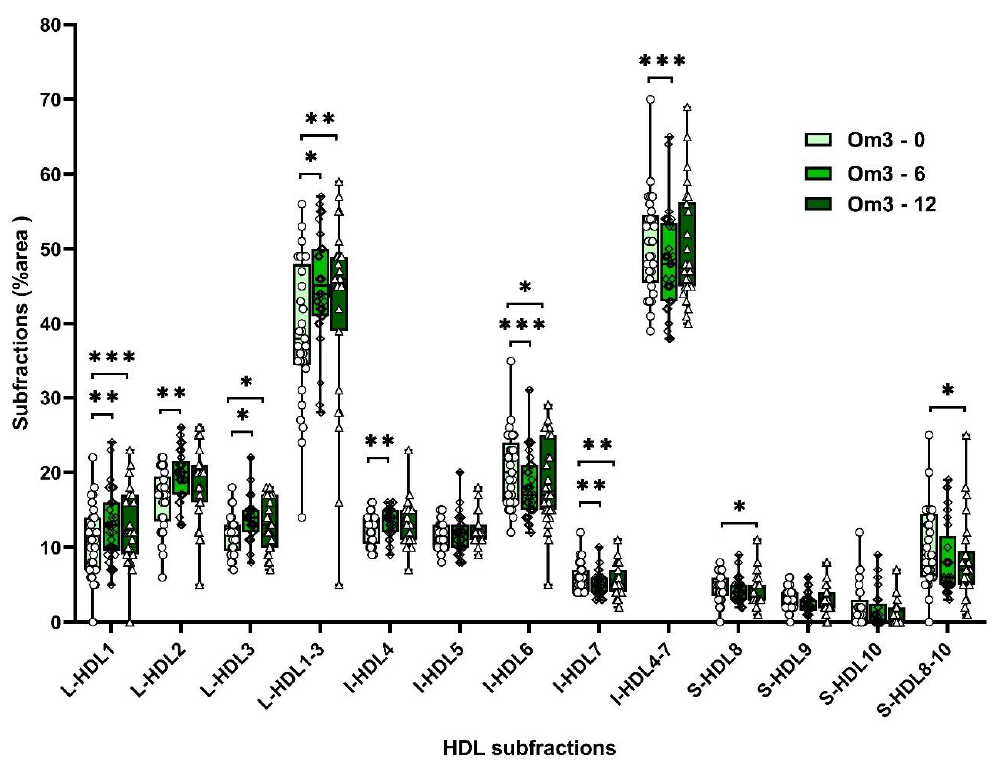
Figure 5. HDL subfractions in Om3 group at the baseline and after 6 and 12 weeks of supplementation. HDL—high-density lipoprotein, L-HDL—large HDL subfraction, I-HDL—intermediate HDL subfraction, S-HDL—small HDL subfraction, Om3—omega 3 group, * p < 0.5, ** p